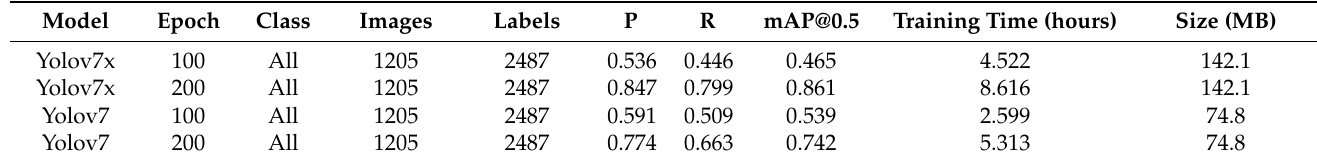
Table 1. Training performance of Yolov7 and